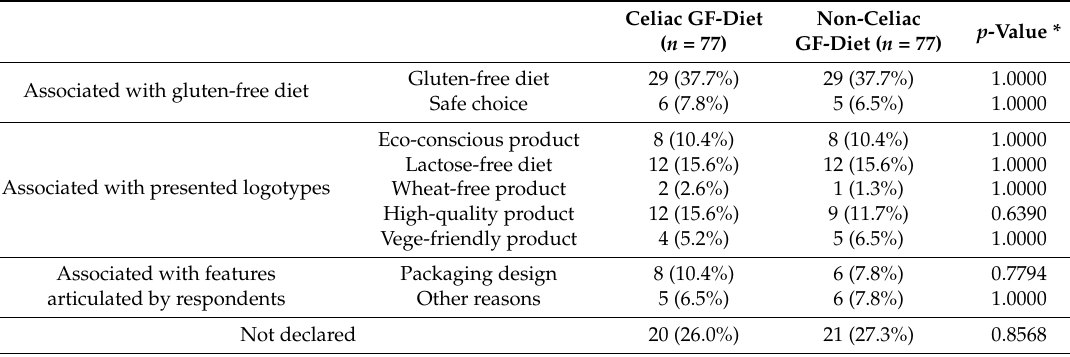
Table 5. The reasons of choice of “gluten-free” (GF) bread in subgroups of celiac GF-diet and non-celiac GF-diet participants (multiple choice based on open-ended